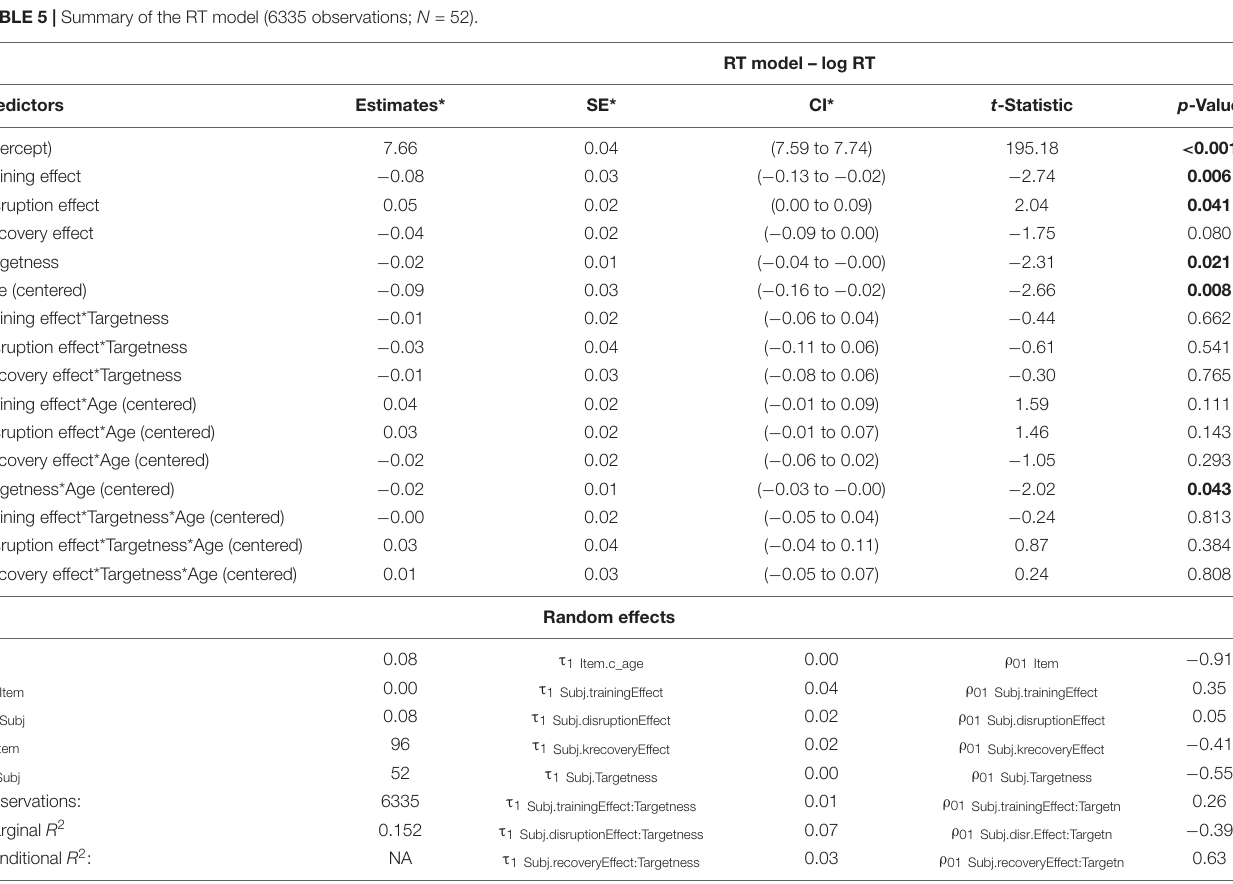
TABLE 5 | Summary of the RT model (6335 observations; N =